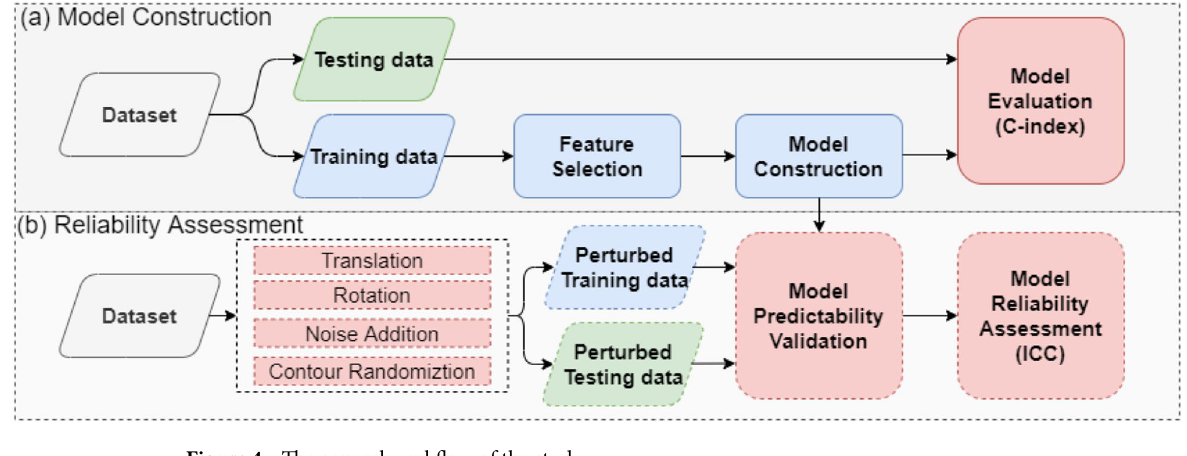
Figure 4. The general workflow of the study.